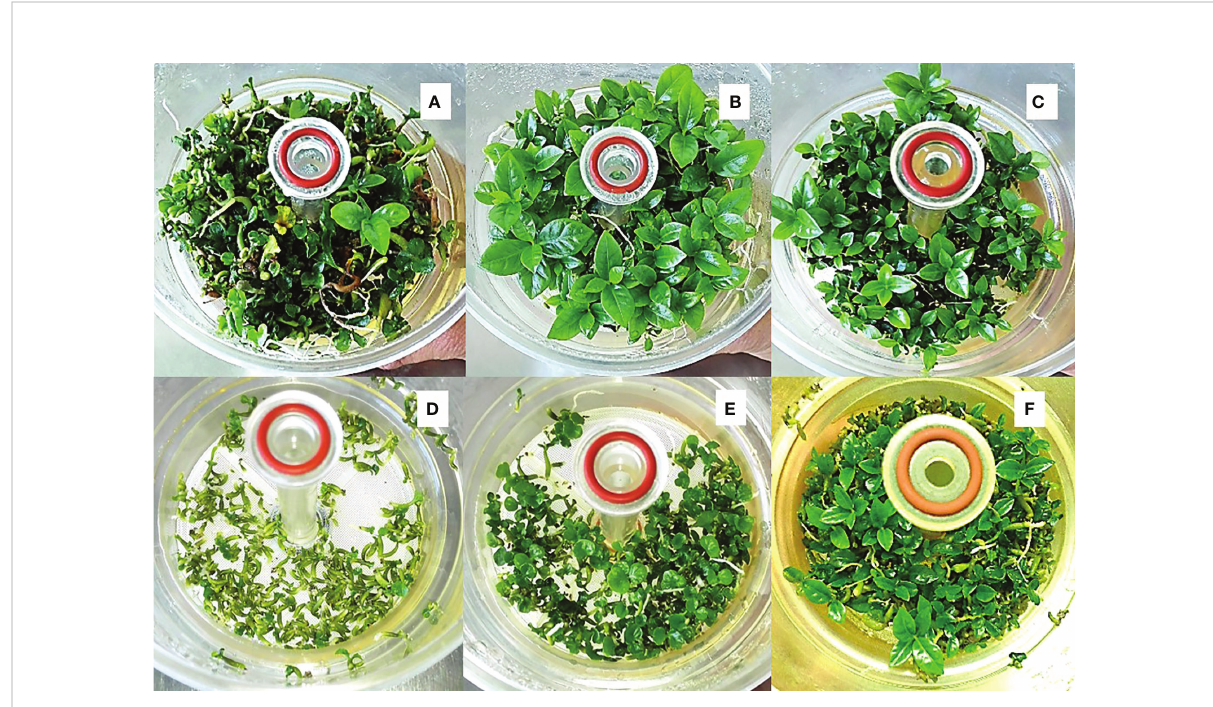
FIGURE 5 Germination of somatic embryos and conversion into plants in liquid T5 culture medium in RITA ® bioreactors. (A) Control culture, with a frequency of two daily immersions of one minute; observe the asynchrony in the development and hyperhydricity of the culture; (B) good quality plants cultured using 2 one-minute immersions every 48 h; (C) plants cultured using 1 immersion every 48 h; (D) green embryos after the fi rst month of culture in RITA ® ; (E) embryos in the cotyledon stage in the second month of culture in RITA ® ; (F) plants with one or two pairs of leaves in the third month of culture in RITA ®